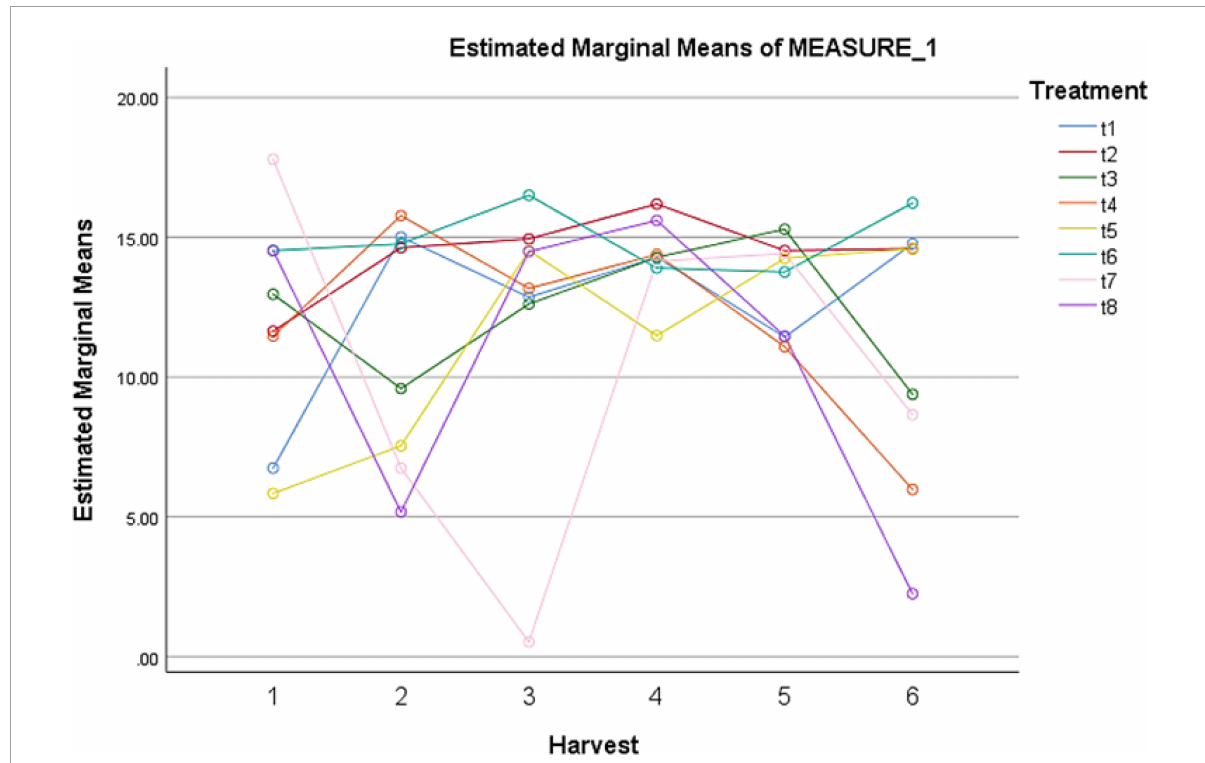
FIGURE5 Effect of different treatments of elicitors on SOD levels of Silybum marianum in hydroponics. The harvest time is on x -axis; 1 = 24 h, 2 = 48 h, 3 = 72 h, 4 = 96 h, 5 = 120 h, 6 = 144 h. For different treatments, t1 = control, t2 = methyl jasmonate, t3 = silver nanoparticles, t4 = fungal elicitors, t5 = methyl jasmonate + fungal elicitors, t6 = methyl jasmonate + silver nanoparticles, t7 = fungal elicitors + Silver nanoparticles, t8 = methyl jasmonate + silver nanoparticles + fungal